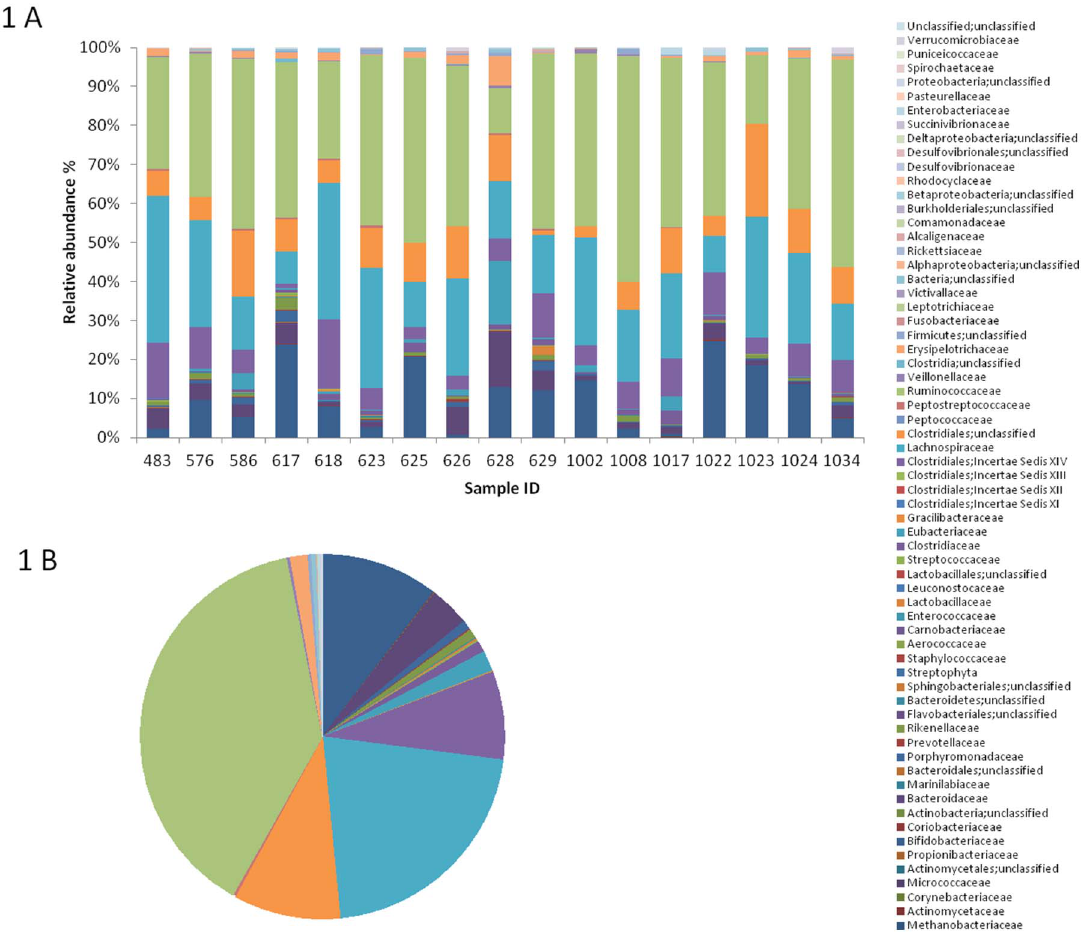
Figure 1. Individual (A) and average (B) gut microbiota profiles of the enrolled DS persons. Relative abundance of family-level assigned OTUs is reported. Colors were assigned for all families